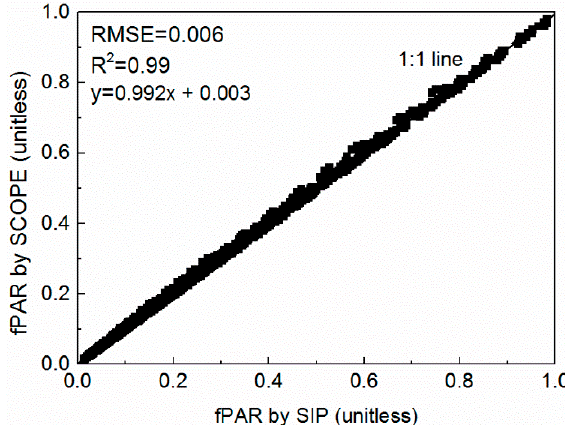
Figure 5. The evaluation of the SIP model by the widely-used SCOPE model at different canopy structures,